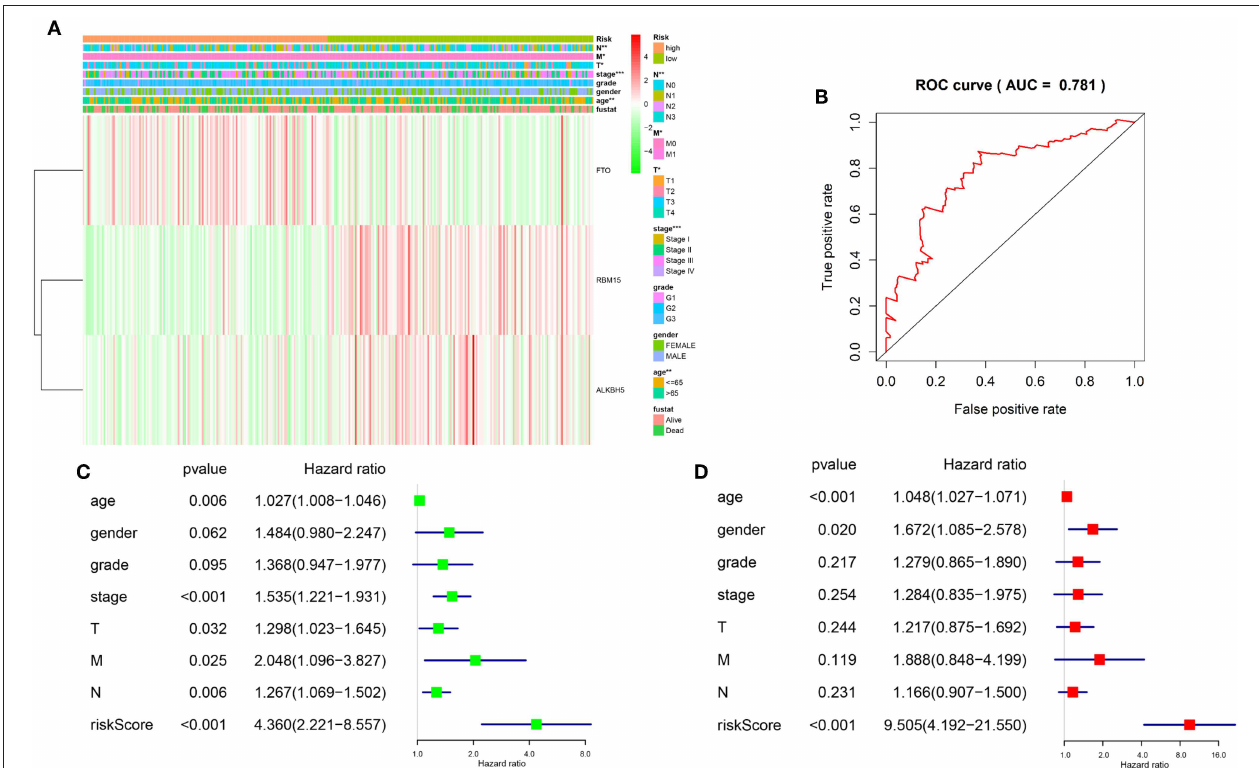
FIGURE 5 | Relationship between the risk score, clinicopathological features, and clusters subgroups. (A) The heatmap shows the expression levels of the three m 6 A RNA methylation regulators in low and high risk gastric cancer patients. The distribution of clinicopathological features was compared between the low- and high-risk groups. (B) ROC curves showed the predictive efficiency of the risk signature. (C) Univariate Cox regression analyses of the association between clinicopathological factors (including the risk score) and overall survival of patients in the TCGA datasets. (D) Multivariate Cox regression analyses of the association between clinicopathological factors (including the risk score) and overall survival of patients in the TCGA datasets. * P < 0.05, ** P < 0.01, and *** P <